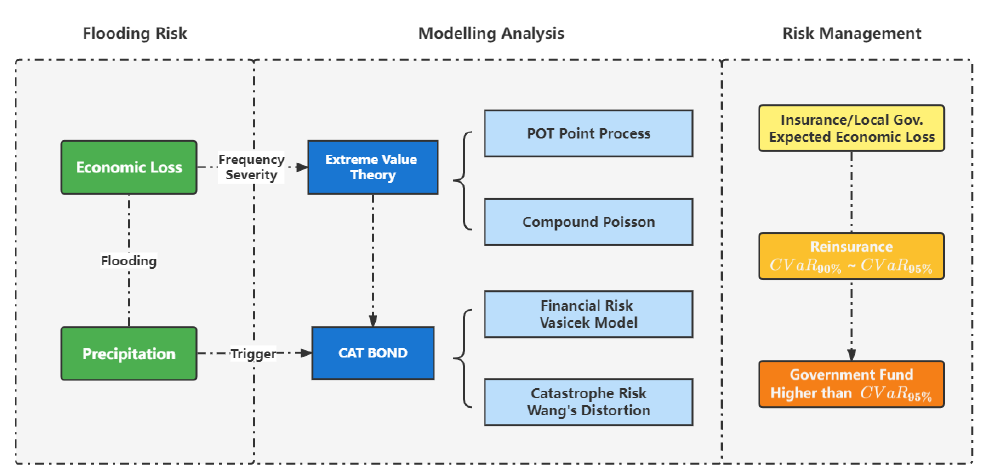
Figure 1. Workflow of flooding risk